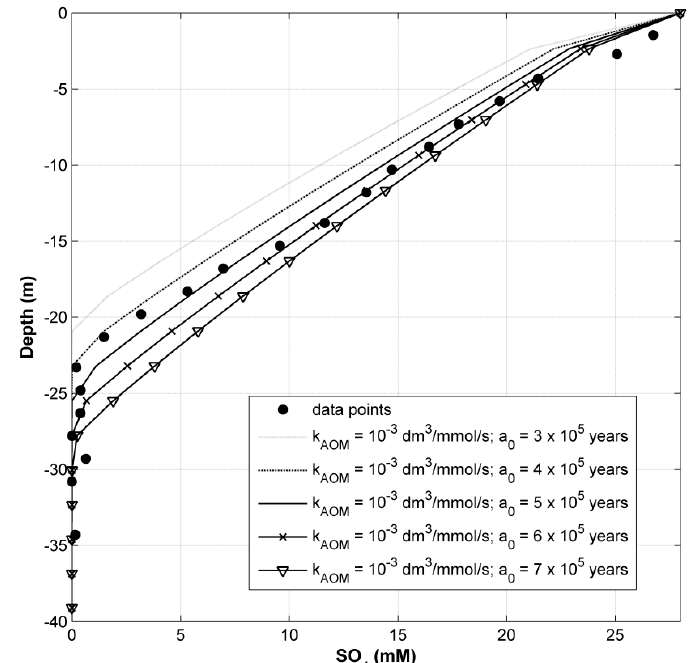
Figure 11. Sensitivity tests on the modeling results of Scenario 2a shown for the upper 40 m of sediments. Model sensitivity to the initial age of organic matter decomposition was explored. The best fit was obtained with a value of 5 × 10 5 years.